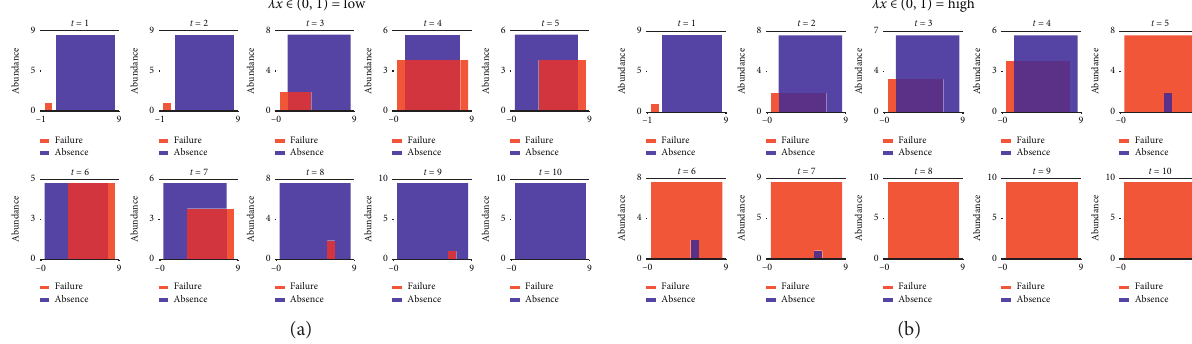
Figure 2: Visualization of the failure propagation with distribution. The plot onthe left ( λ x � low) and right ( λ x � high) shows the number of failures for time step ( t � 10) with the corresponding proportional area to the values. The area is the percentage of an event representing the values that lie within ranges; lower bounds (horizontal axis � arbitrary unit) and upper bound (vertical axis � abundance). It shows the more the propagates, the bigger the area has been drawn between the failure (red) and the absence of failure (blue) at each time